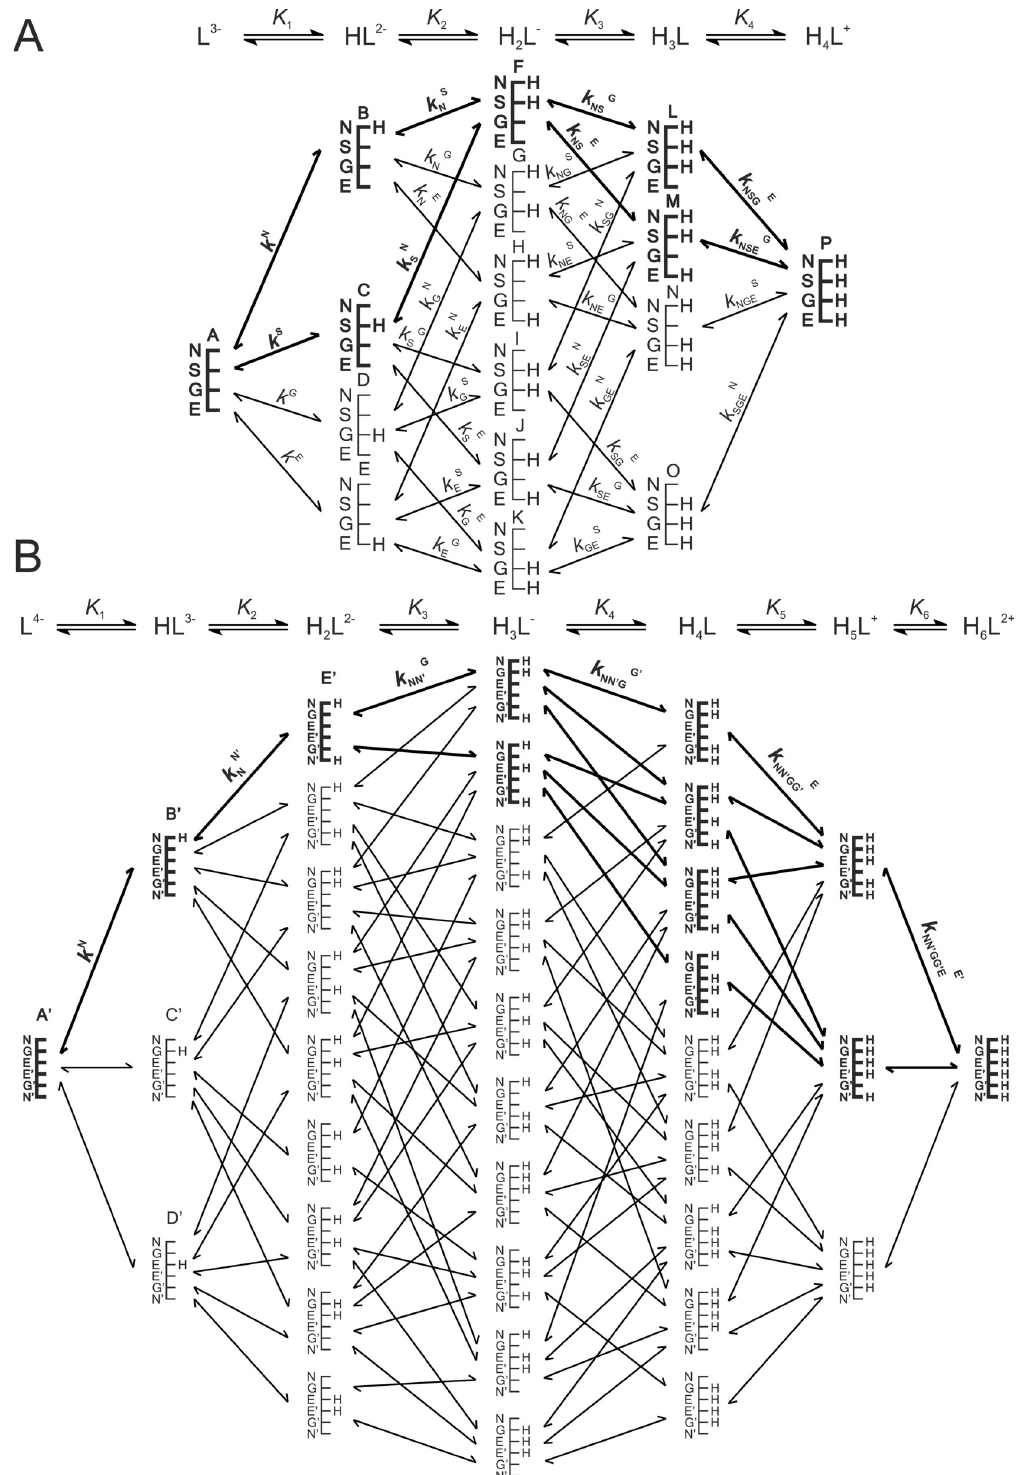
Fig 3. This figure was reproduced from [6, 10]. The protonation macro- and microequilibrium schemes of glutathione GSH (A) and glutathione disulfide GSSG (B) are presented in a similar fashion to Fig 1. For the symmetrical glutathione disulfide only non-identical microspecies and microconstants are shown, and only a few of the microconstants are labeled. The components of the major pathways are in bold. The basic moieties are depicted with their one-letter symbols: N (amino), S (thiolate), G (glycyl carboxylate), and E (glutamyl carboxylate). https://doi.org/10.1371/journal.pone.0264866.g003 PLOS ONE | https://doi.org/10.1371/journal.pone.0264866 March 11,